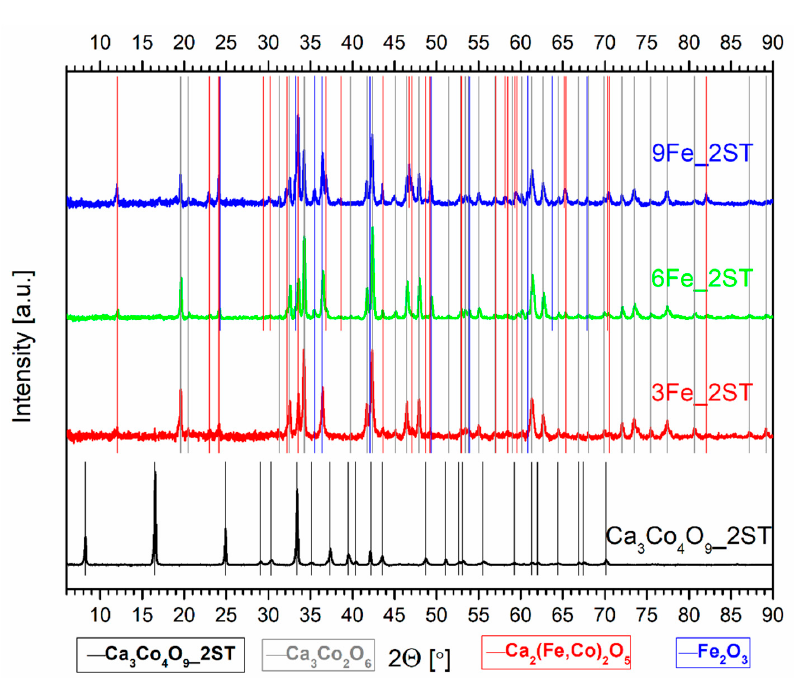
Figure 6. Normalized XRD patterns of the 2ST sintered reference matrix and Fe added samples. The vertical lines of different colors mark the main identified phases.